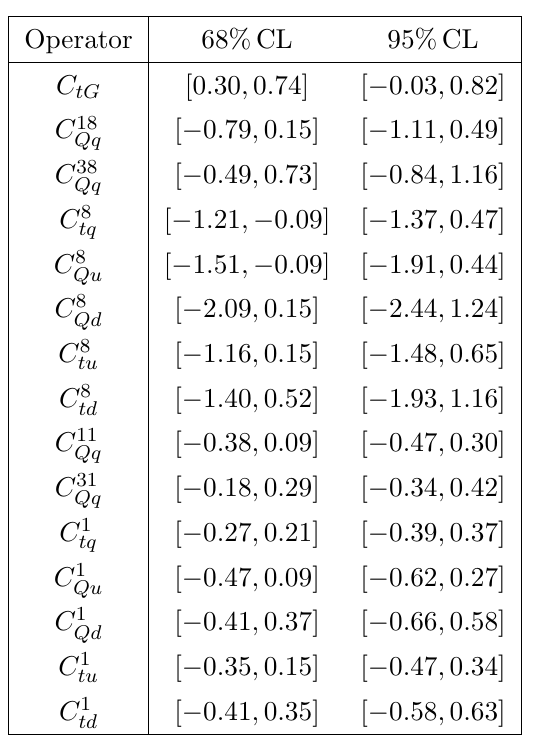
Table 8 . Bounds on the Wilson coe(cid:14)cients C i in units of (TeV = (cid:3)) 2 at 68% and 95% con(cid:12)dence level from a global (cid:12)t to observables in top pair